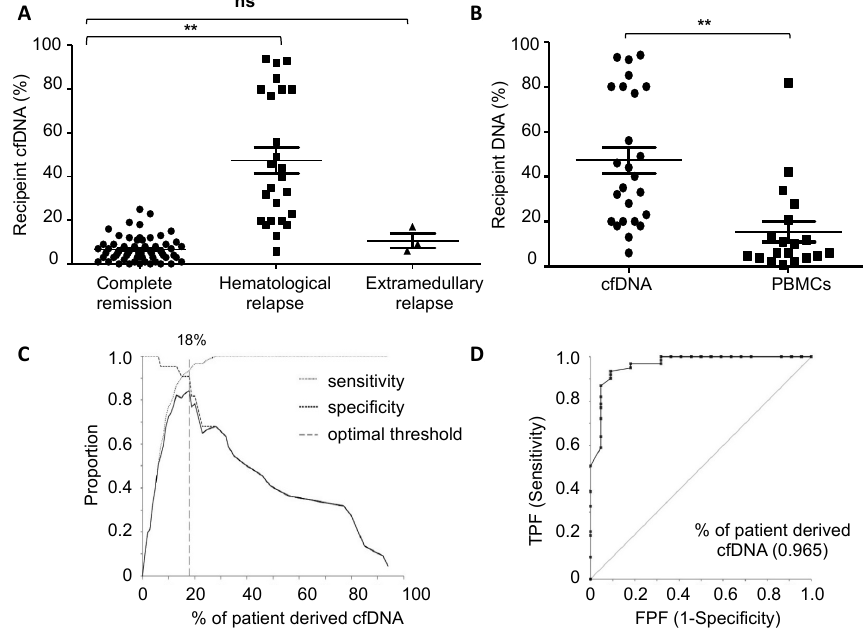
Figure 1. Chimerism assessment in cfDNA after allo-HSCT. ( A ) Graph represents the recipient-derived cfDNA after allo-HSCT in patients with hematological relapse ( ■ ), in complete hematological remission ( ● ) and with extramedullary relapse ( ▲ ). ( B ) Comparison of recipient-derived DNA in cfDNA ( • ) and in PBMCs ( (cid:4) ) in patients with hematological relapse. Each dot represents a patient, long bars represent the mean and the short bars the standard deviation. ** p -value < 0.01, n.s. not significant. ( C ) The resulting area under the curve (AUC: 0.968) revealed cfDNA chimerism analysis as an adequate assay for discriminating relapse from non-relapse. The optimal threshold that discriminates relapse from non-relapse was derived from Youden index and resulted to be 18% of recipient-derived cfDNA. ( D ) To analyze the general performance of cfDNA chimerism assay the true-positive rate (sensitivity) and false-positive rate (1-specificity) was plotted in a receiver operating characteristic (ROC) space. The ROC curve (black line) represents true positive fraction (TPF) against the false positive fraction (FPF). The diagonal (gray line) corresponds to random chance. cfDNA, circulating-free DNA; allo-HSCT, allogeneic hematopoietic stem cell transplantation; PBMCs, peripheral blood mononuclear cells; TPF, true-positive fraction; FPF, false-positive fraction. After performing the ROC curve, the obtained area under the curve was 0.968 (95% CI; 0.929–1.003, p -value < 0.001) and the optimal discriminating threshold between